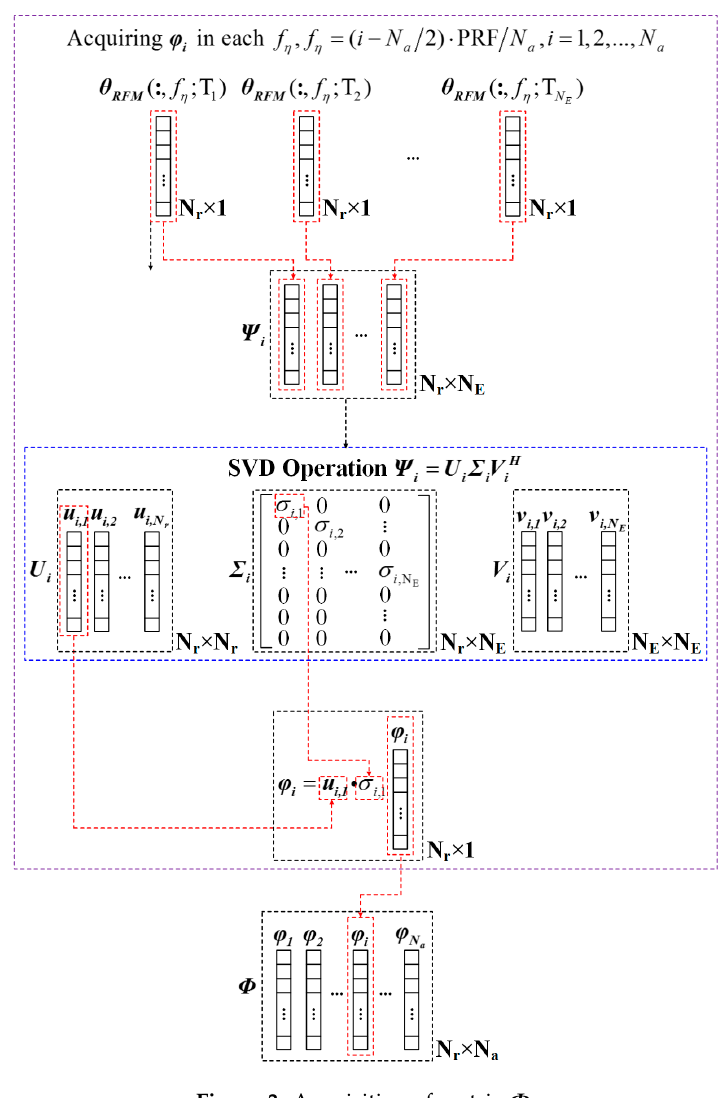
Figure 3. Acquisition of matrix Φ .